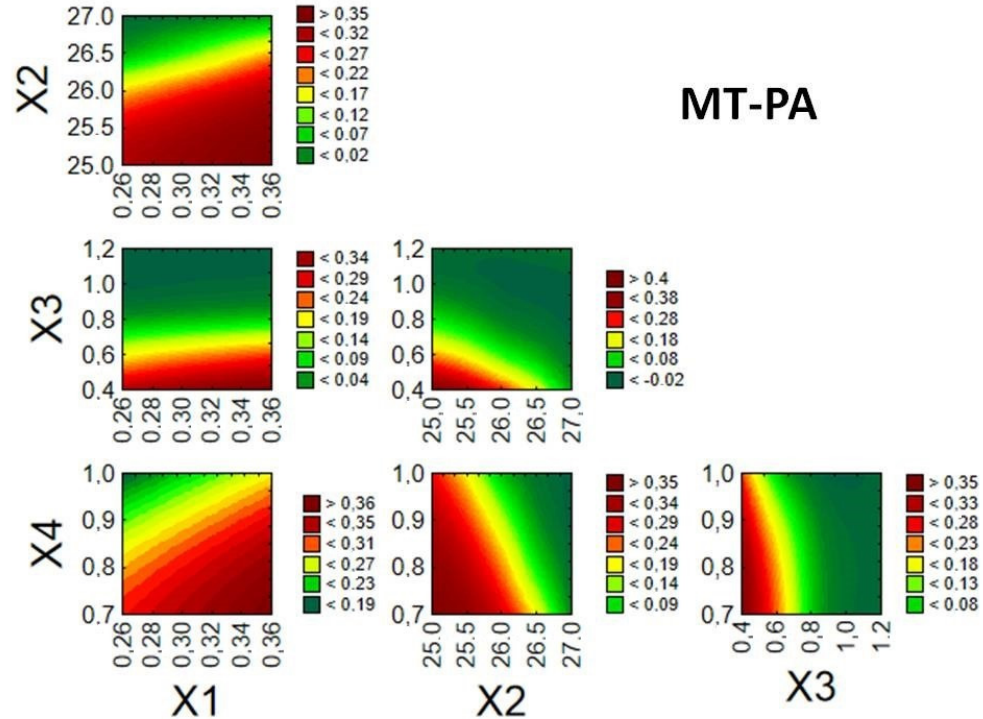
Figure 5. Desirability plots for response surface prediction of MT-PA showing interactions between factors X1–X4.